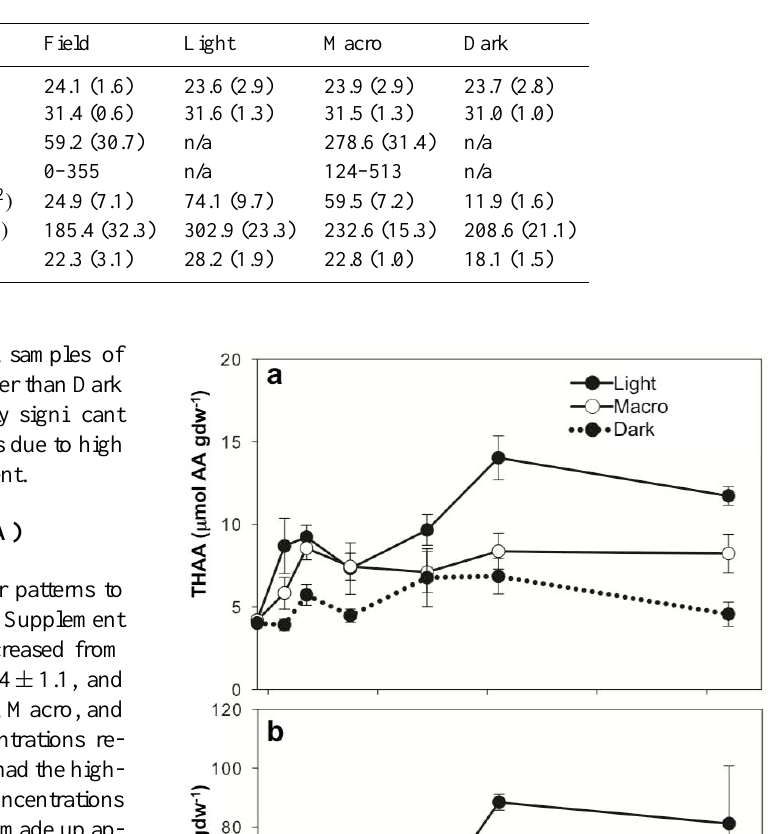
Table 2. Parameters measured concurrently at Hog Island Bay field sites and in mesocosms. Field samples were collected from a mid-lagoon site on three dates while the mesocosm experiment was being conducted. Mesocosm values are means of daily means across all time steps. Values are presented as the mean (SE) for field ( n = 5) and mesocosm treatments ( n = 9).